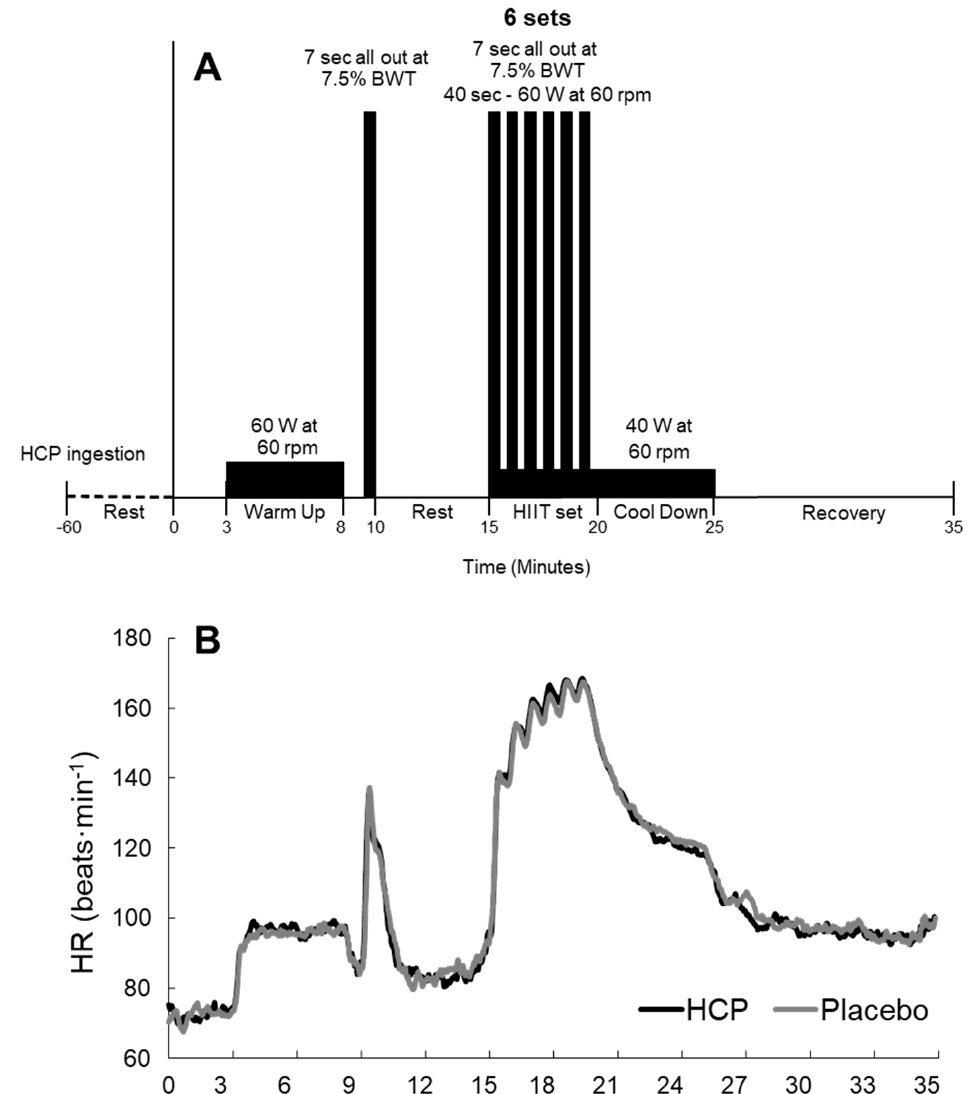
Figure 1. Experimental flow protocol at rest, warm − up, high − intensity intermittent training (HIIT), cool down, and passive recovery ( A ), and the heart rate (HR) response during rest, HITT, and recovery ( B ) in the HCP and placebo groups. HR reflecting the exercise intensity reached values near maximal intensity during the HIIT protocol.